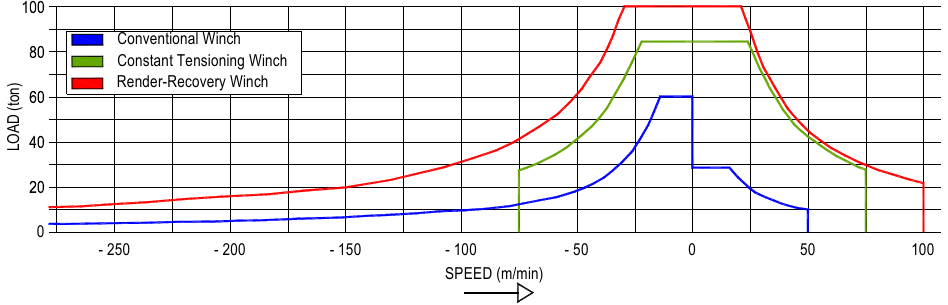
Figure 8. Typical parameters of conventional, constant tensioning and render-recovery winches [17]. Drawing: